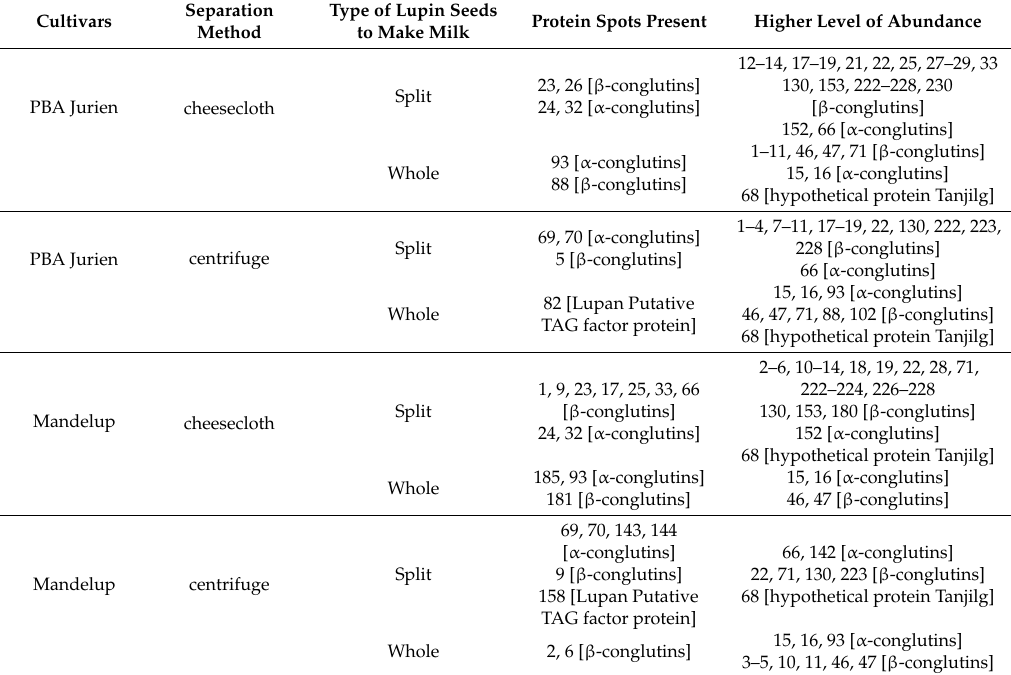
Table 3. List of the lupin proteins with respect to extractability in the lupin milk as influenced by seed